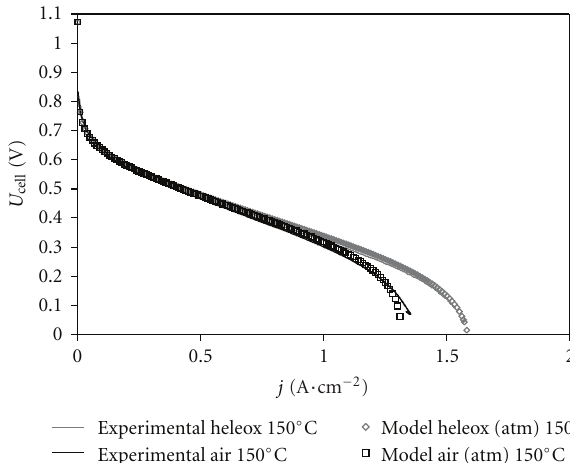
Figure 6: Comparison between modelled and experimental results for HT-PEMFC utilising 50% Pt/C at the cathode and 20% Pt/C on the anode at temperature of 150 ◦ C using air and heleox mixture; alpha value of 0.75 and γ = 1 . 375 was used for the cathode.